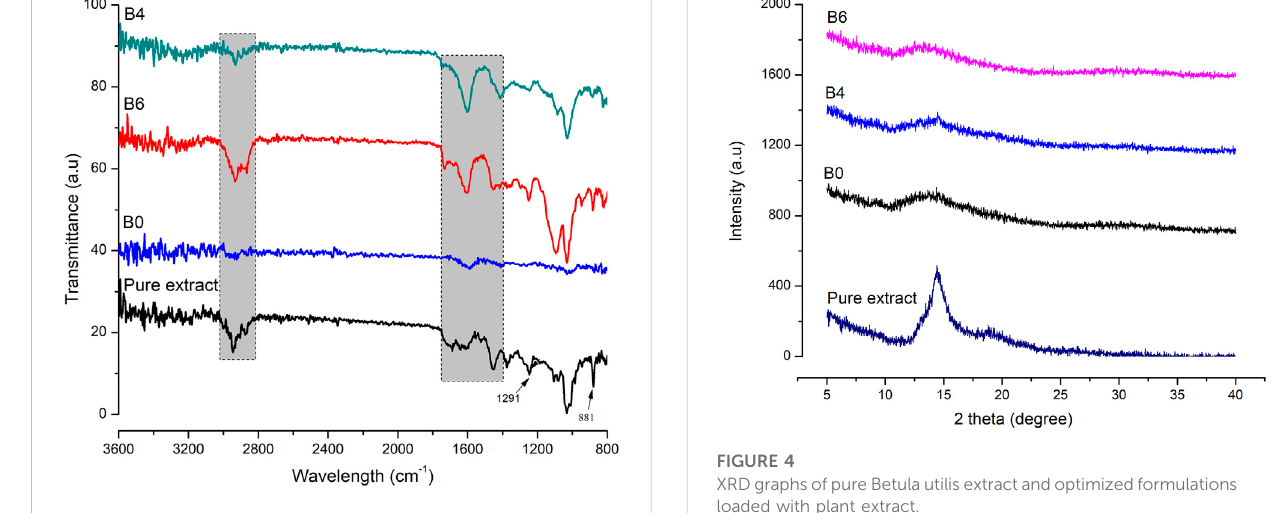
Figure 3. Sodium alginate in blank fi lm displayed stretching vibrations of O – H in the range of 3000 – 3600 cm − 1 . Stretching of the aliphatic C – H group was found between 2920 and 2850 cm − 1 .